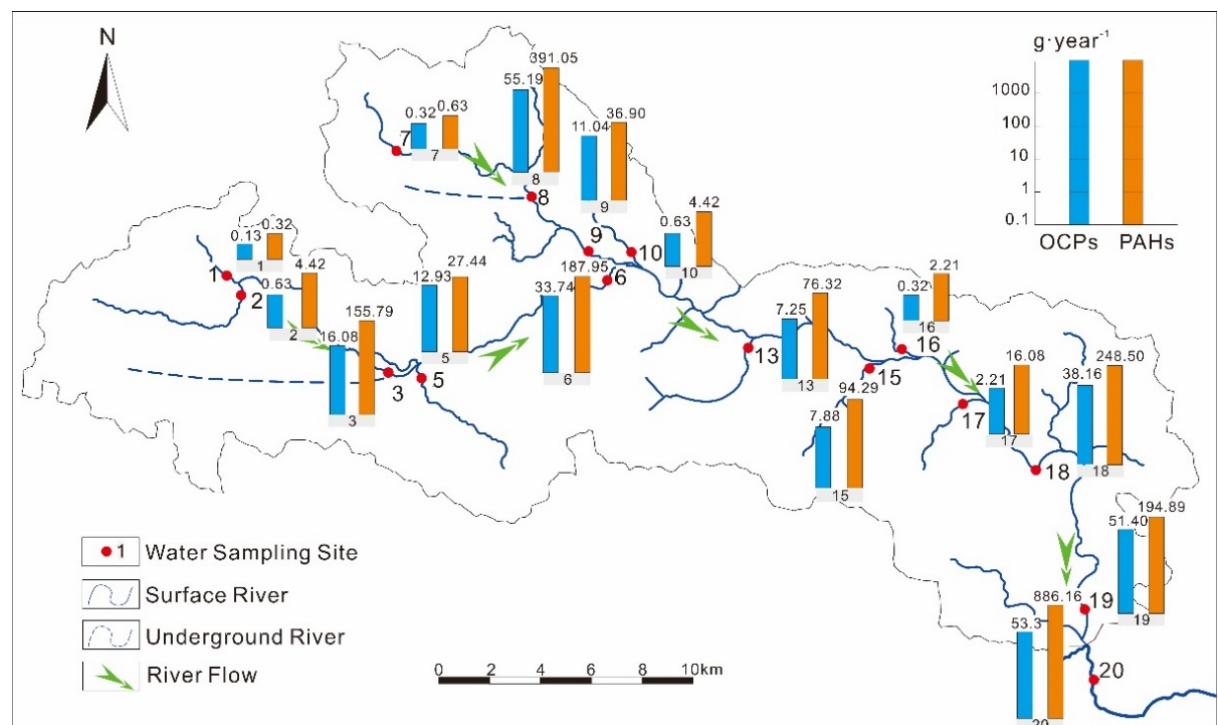
Figure 5. Mass fluxes (g · year − 1 ) of OCPs and PAHs along the Danshui River.